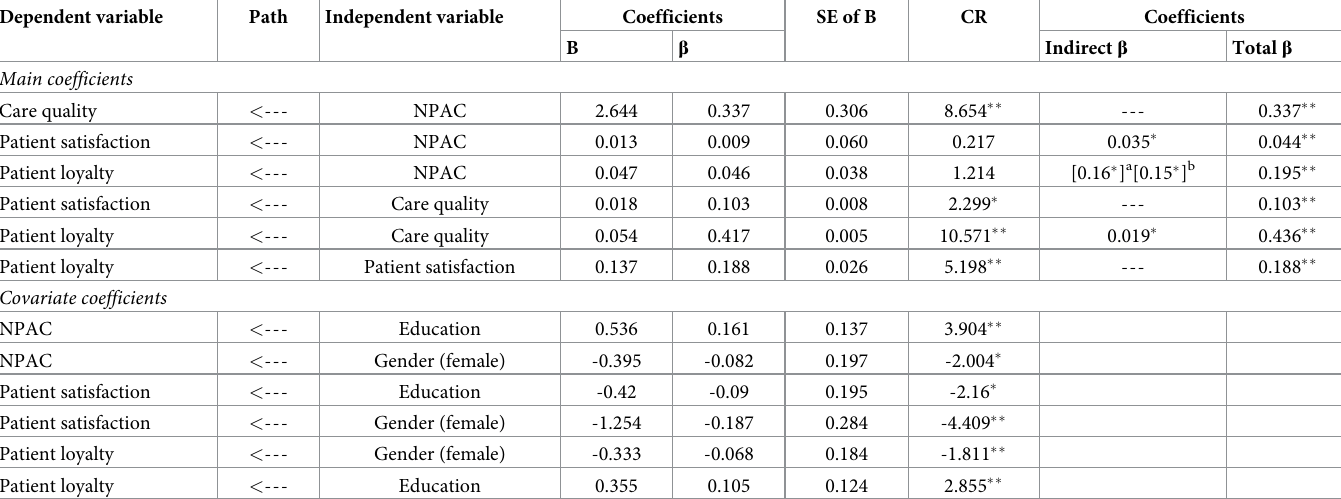
Table 4. The relationships between NPAC, care quality, patient satisfaction, and patient loyalty ( n =